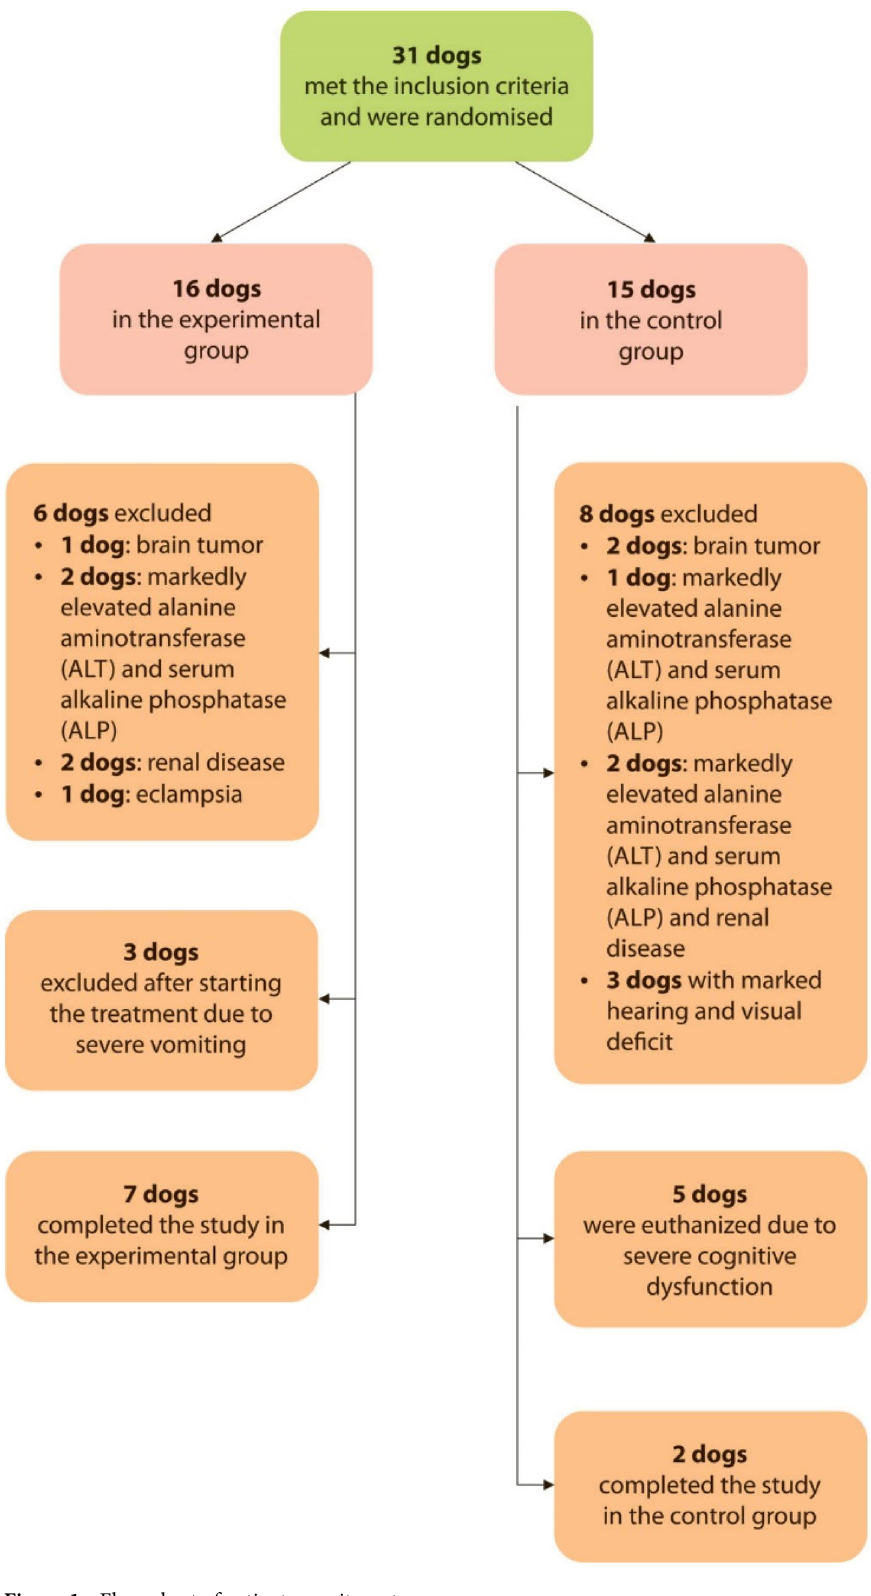
Figure 1. Flow-chart of patient